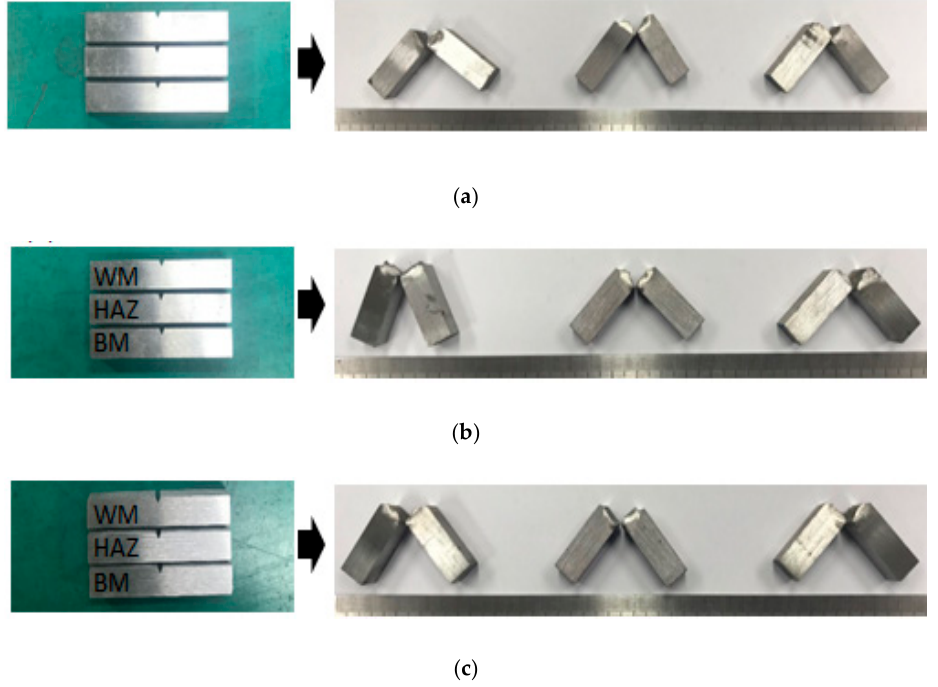
Figure 11. Prepared impact test specimens and tested specimens. ( a ) BM (Base metal). ( b ) FCAW. ( c ) LBW.